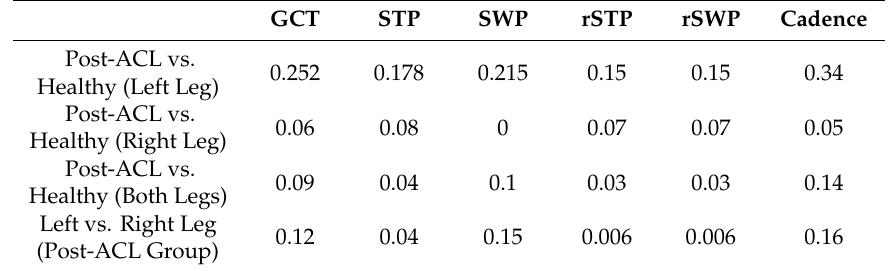
Table 4. E ff ect sizes